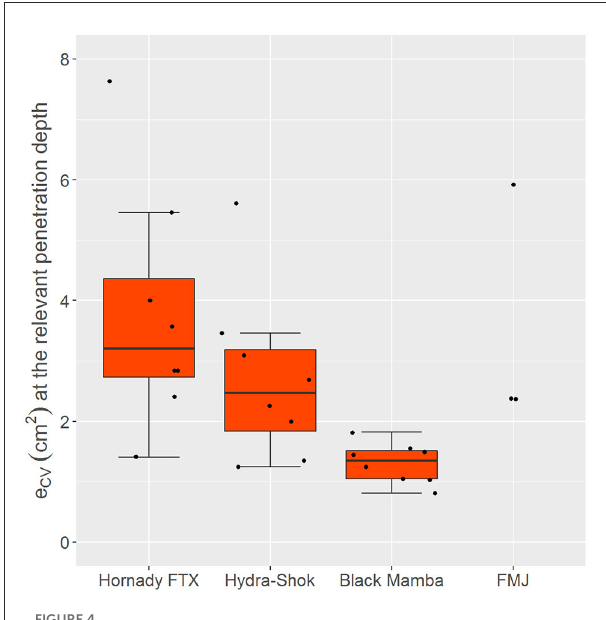
FIGURE4 Boxplots of the mean cross-sectional extent of the cavity volume (e CV ) in cm 2 along the relevant section of the penetration depth into the soap block (5.5–7.5cm). The mean volume extent of the Hornady FTX and the Hydra-Shok was larger than that of the Black Mamba . Outlier were observed for the Hornady FTX (7.63 cm 2 ) and the Hydra-Shok (5.61 cm 2 ). The FMJ achieved values comparable to the Hydra-Shok , assuming an outlier at 5.92 cm 2 .